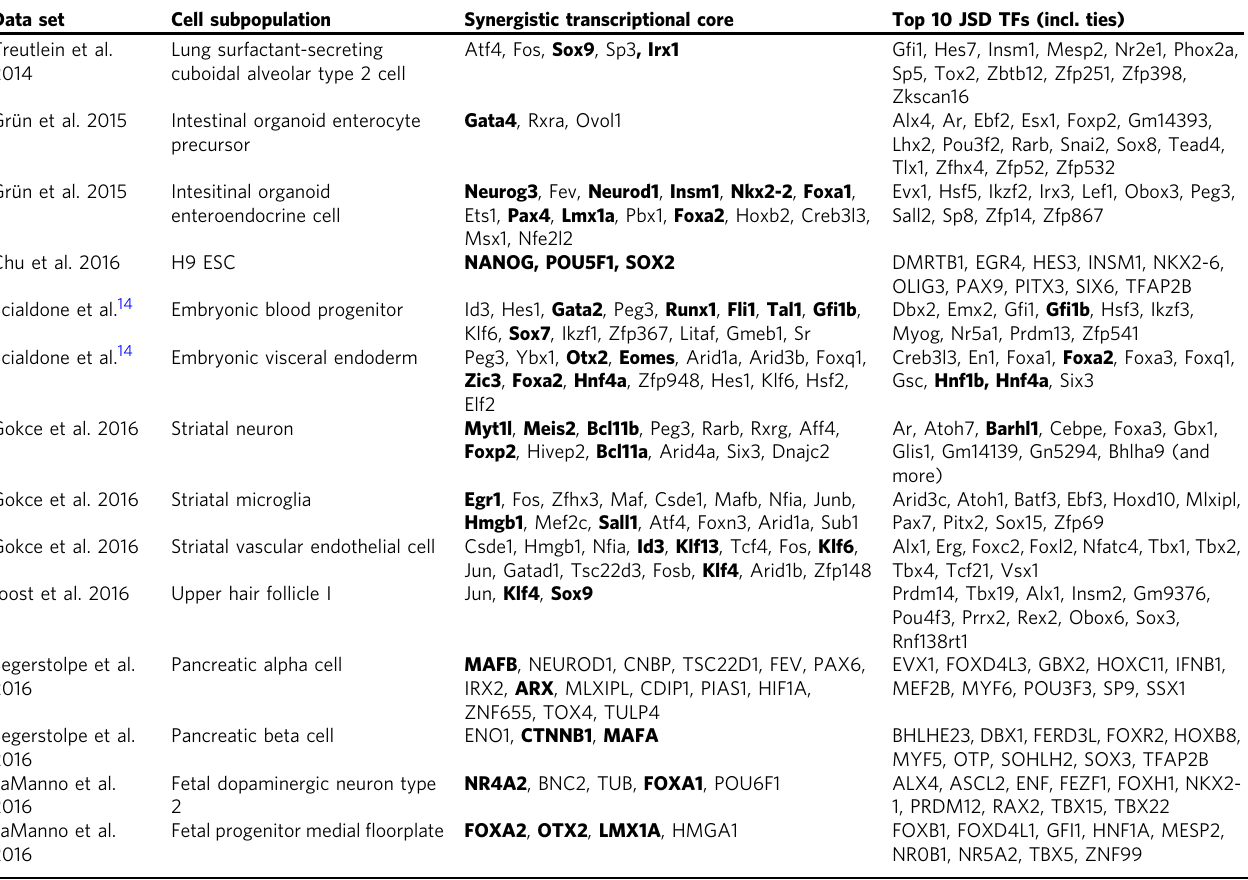
Table 1 Most synergistic transcriptional cores predicted by TransSyn and top 10 JSD TFs in example subpopulations, where known identity TFs are in